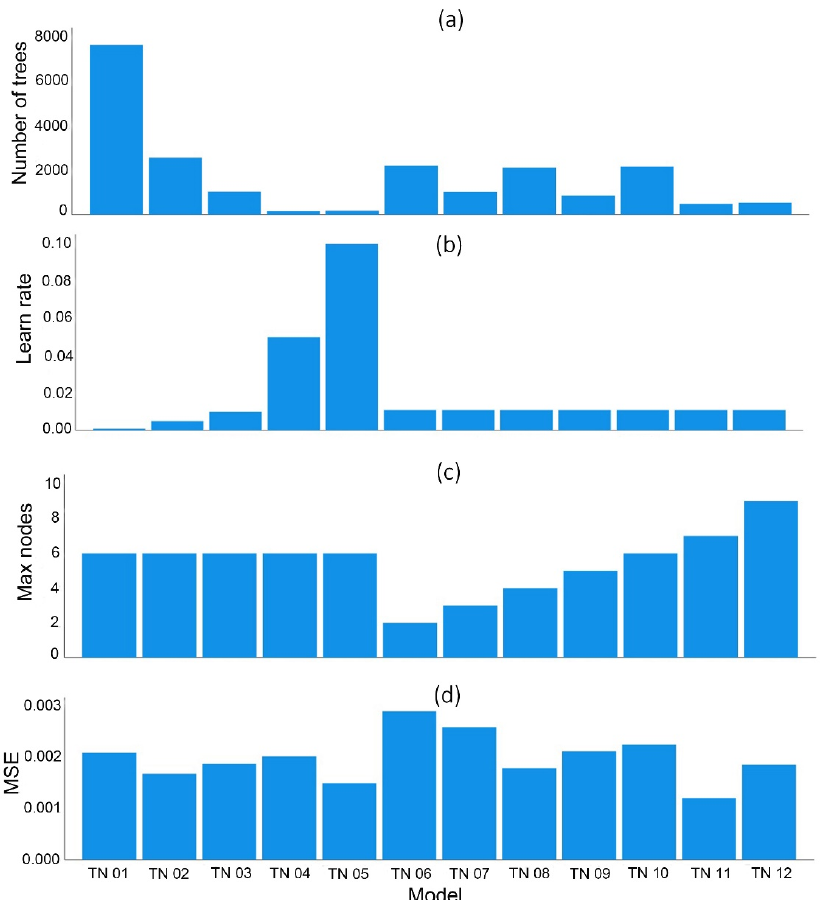
Figure 5. Comparison between different TreeNet (TN) models regarding ( a ) the number of trees, ( b ) learning rates, and ( c ) tree complexity for determining optimal TreeNet model based on ( d ) the mean square error (MSE).